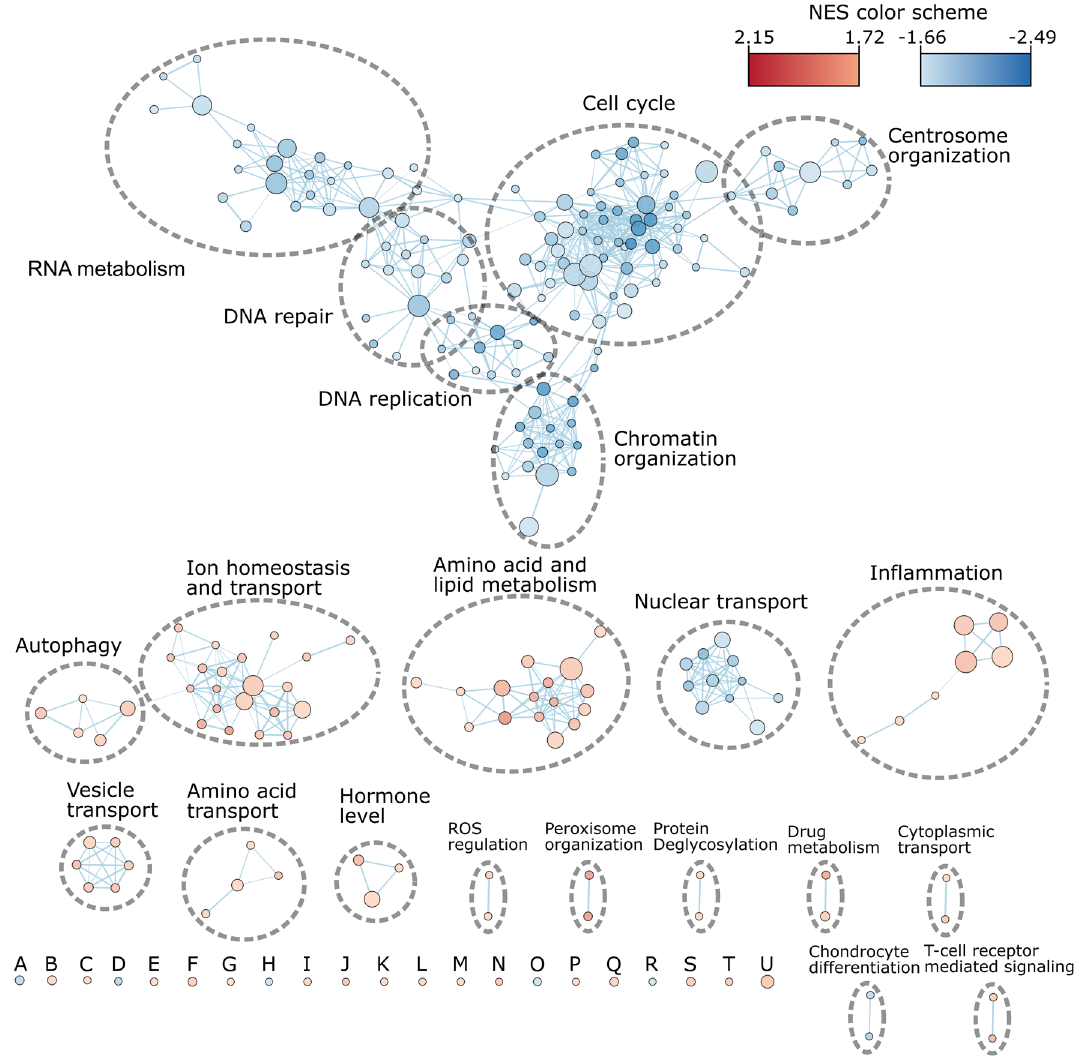
Figure 4. Enrichment map for significant downregulated GO-terms in biological processes for the comparison of Sus_CDM2 against Adh_CDM2 (threshold at FDR of 0.05). The size of the node is proportional to the number of identified genes annotated to the GO-term. The thickness of edges represents the level of overlap between the GO-terms. A: DNA templated transcription termination, B: Aerobic respiration, C: Response to increased oxygen levels, D: Protein peptidyl prolyl isomerization, E: Cofactor transport, F: positive regulation of inflammatory response, G: Cellular response to fluid shear stress, H: Regulation of ubiquitin protein ligase activity, I: Establishment of endothelial barrier, J: Hyperosmotic response, K: Regulation of protein oligomerization, L: Excitatory synapse assembly, M: Regulation of calcineurin mediated signaling, N: Modified amino acid transport, O: Cell migration involved in sprouting angiogenesis, P: Low density lipoprotein receptor particle metabolic process, Q: Endosome organization, R: Pyrimidine nucleotide triphosphate biosynthetic process, S: Water soluble vitamin metabolic process, T: Collagen catabolic process, U: Drug metabolic process. NES: Normalized enrichment score; The complete gene set list with group association is shown in Supplementary Table